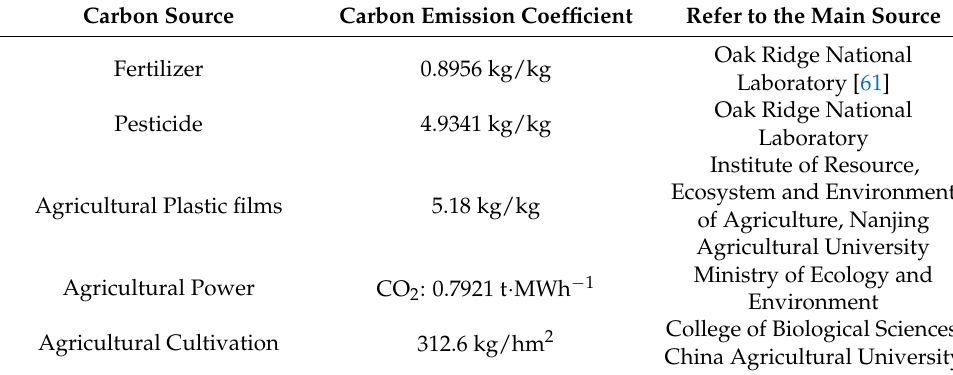
Table 2. Carbon emission factors and reference